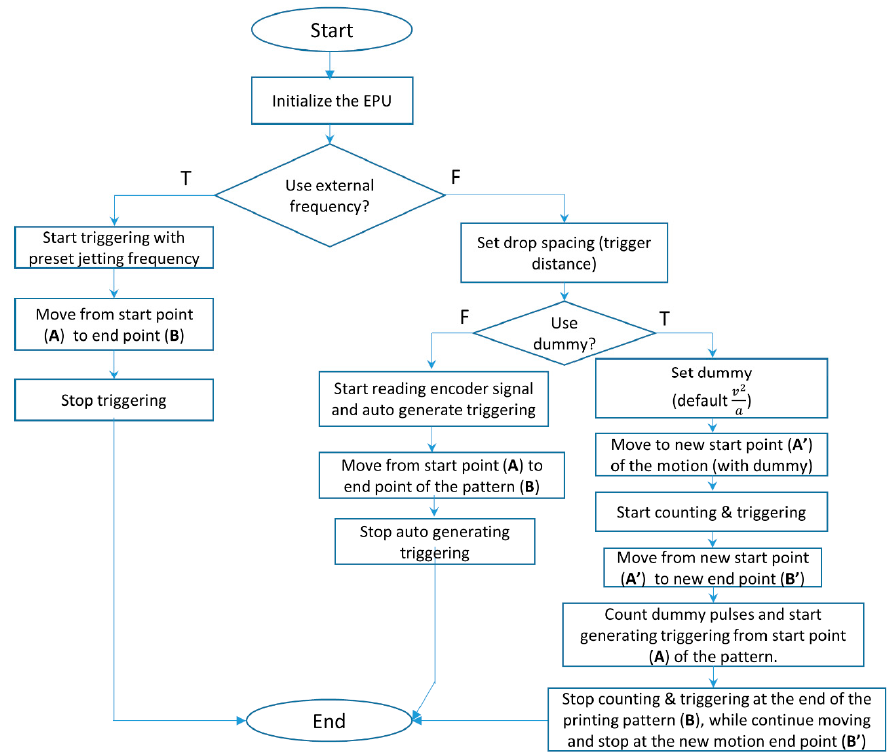
Figure 10. Flow chart for printing CAD-based line printing using the EPU.